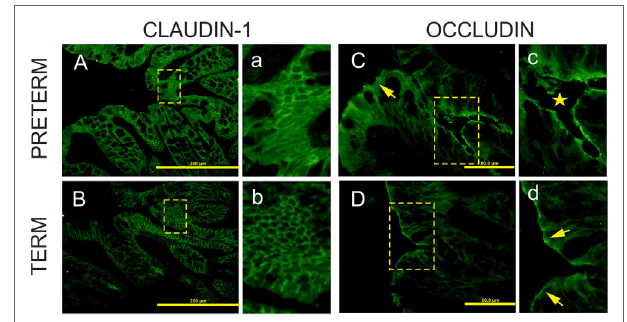
FigUre 3 | Immunofluorescent localization of claudin-1 and occludin in the colon of the preterm and term germ-free piglets. Cryosections of the colon of the preterm [ (a,c) a,c] and the term [ (B,D) b,d] germ-free piglets were stained for the tight junction proteins claudin-1 [ (a,B) a,b] and occludin [ (c,D) c,d]. Scale bars for claudin-1 (a,B) and occludin (c,D) are at 200 µm and 50 µm, respectively. Panels with small letters represent magnifications of × 2 for claudin-1 (a,b) and × 4 for occludin (c,d) of the selected area (outlined with dashed lines) in the corresponding panels denoted with capital letters. Claudin-1 is expressed uniformly from crypt to surface in epithelial lateral membranes in the colon of both piglet groups [ (a,B) a,b]. In the preterm enterocytes, it is also extensively expressed in the cytoplasm (a). Occludin is expressed at the apical lateral membrane of crypt epithelial cells (c, star), but not in surface epithelial cells in the preterm germ-free piglets [ (c) , arrow]. It is expressed at the apical lateral membrane of crypt cells (not shown here) and at surface epithelial cells in the term piglets (d, arrows). Sections from five piglets were examined for each group.